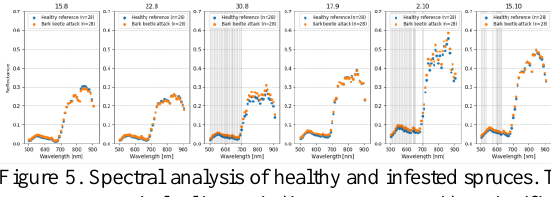
Figure 5. Spectral analysis of healthy and infested spruces. The vertical lines indicate areas with significant differences detected by the variance analysis (p<0.01).